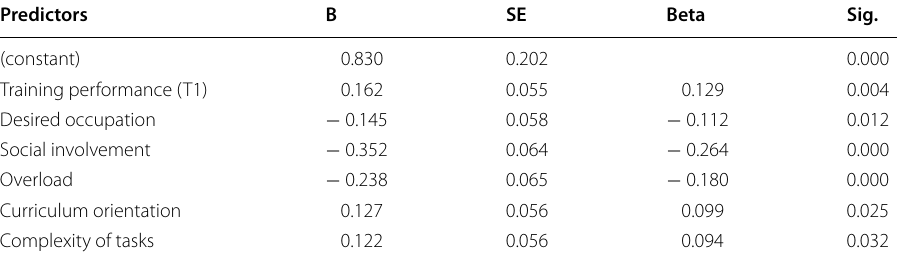
Table 4 Narrow model 2: regression model on horizontal drop-out intention